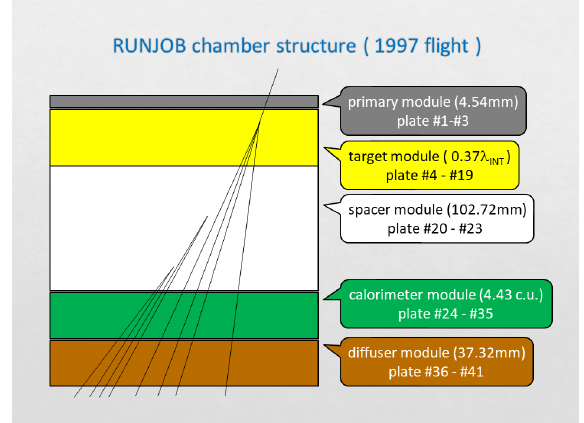
Fig 4. A schematic picture of micro-tracks related to the cosmic ray interaction in Fig.3. Precise relative position among emulsion plates are lost after they were de-packed and